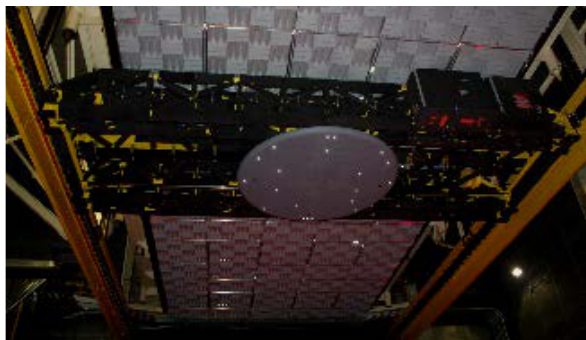
Figure 3. Microphone array disk mounted on the ceiling gantry in the 14x22 tunnel.